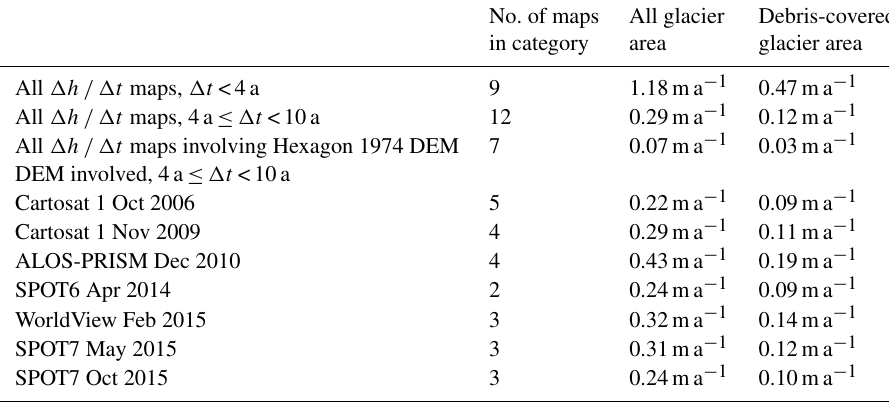
Table 3. Mean ∗ uncertainties associated with different sets of elevation change ( (cid:49)h/(cid:49)t ) maps.